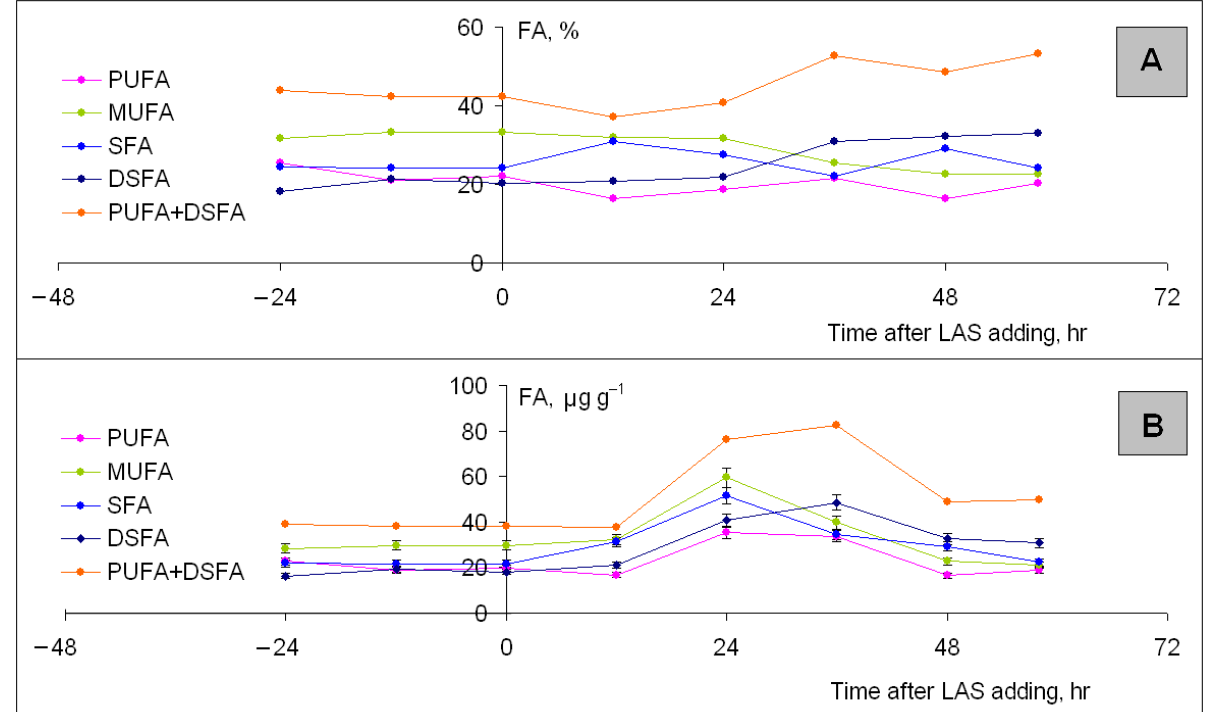
Figure 5. Lubomirskia baikalensis fatty acid composition and content changes. ( A ) — fatty acid compo- sition (%) including saturated, monounsaturated, polyunsaturated, and demospongic acids before anionic surfactant exposure (in the left of the vertical axis) and after linear alkylbenzene sulfonate (LAS) addition into aquarian water (in the right of the vertical axis) to achieve an LAS concentration of 20 μg L – 1 ; ( B ) — fatty acid co ntent (μg g – 1 of d.w.) before and after LAS addition.